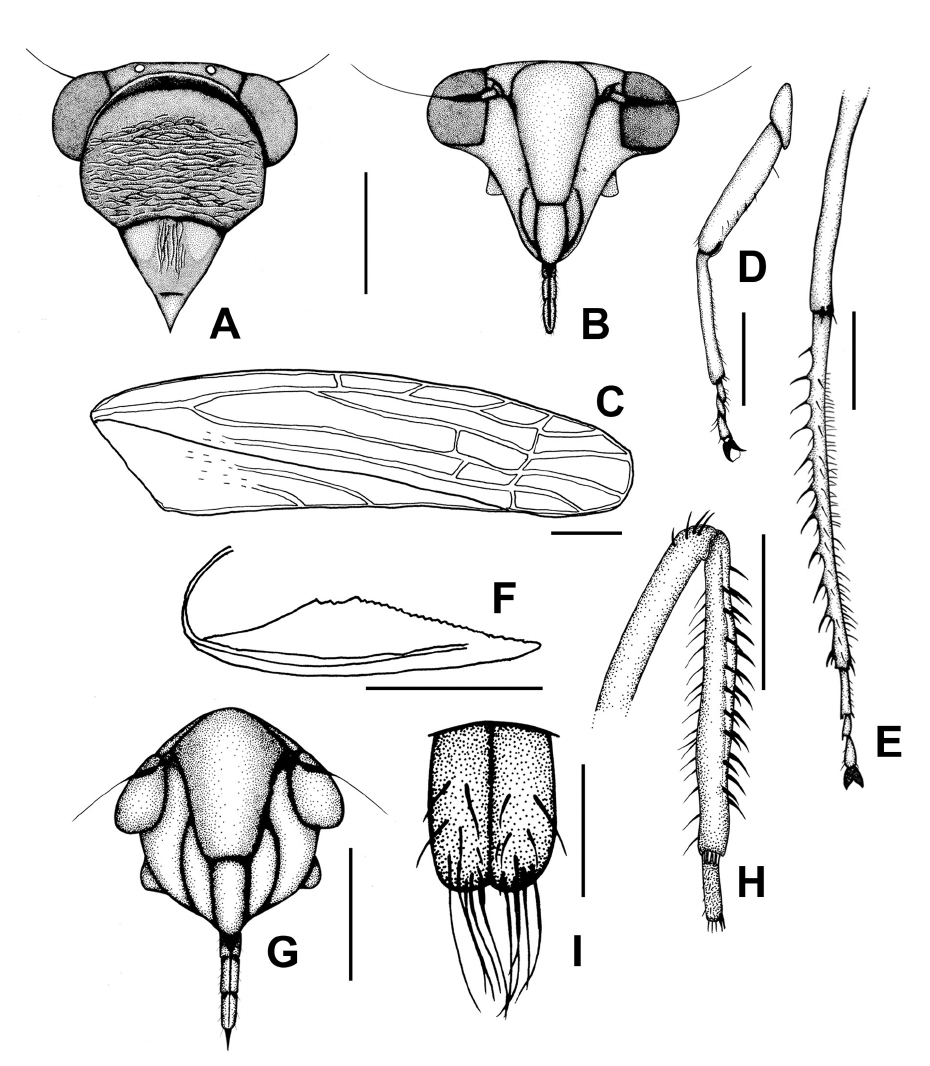
Fig. 2. A-F . Eomegopthalmus lithuaniensis sp. nov. ♀. A . Crown, pronotum, and mesonotum, dorsal view. B . Face, anteroventral view. C . Right forewing, lateral view. D . Prothoracic leg, lateral view. E . Metathoracic leg, dorsal view. F . Second valvulae of ovipositor, general lateral view. G-I . Xestocephalites balticus sp. nov. ♂. G . Face. H . Apical portion of femur, tibia, and first tarsomere of metathoracic leg, lateral view. I . Subgenital plates, ventral view. Scale bars: A-H = 1 mm; I = 0.5